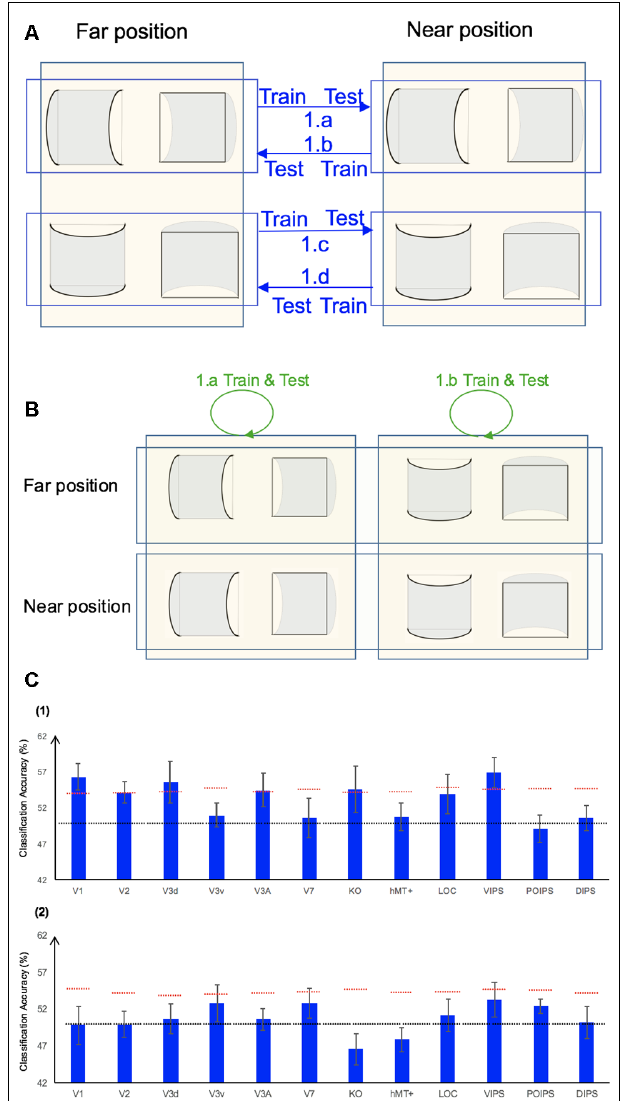
FIGURE 6 | Additional analysis and results. (A) Illustration of the additional types of the sign of curvature classification performed. 1.a, 1.b, 1.c, and 1.d represent the transfer sign of curvature classification that trained the SVM using data of surfaces at the near position and tested the SVM using data of surfaces at the far position, and vice versa (denoted by A1). (B) Illustration of the additional near–far classification performed. We trained and tested the SVM using data of both convex and concave surfaces with the same orientation (denoted by A2). (C) Accuracy of the additional types of classification. (1) The accuracy of classification for the additional classification A1. (2) The accuracy of classification for the additional classification A2. The red horizontal dotted lines indicate the baselines of statistical significance for the ROIs. The locations of these lines indicate the upper 99.6% percentile of the distribution of the accuracy of classification of the permutated data. The black horizontal line indicates the chance level for two-class